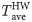
The frequency distributions of heat wave characteristics in Guangzhou, China (1980–2014).The Y-axes are the frequency (count), the X-axes are (a) year of occurrence, (b) onset day (DOY), (c) duration (days), (d) average daily mean temperature (TaveHW), (e) maximum of the daily maximum temperature (TmaxHW), respectively.